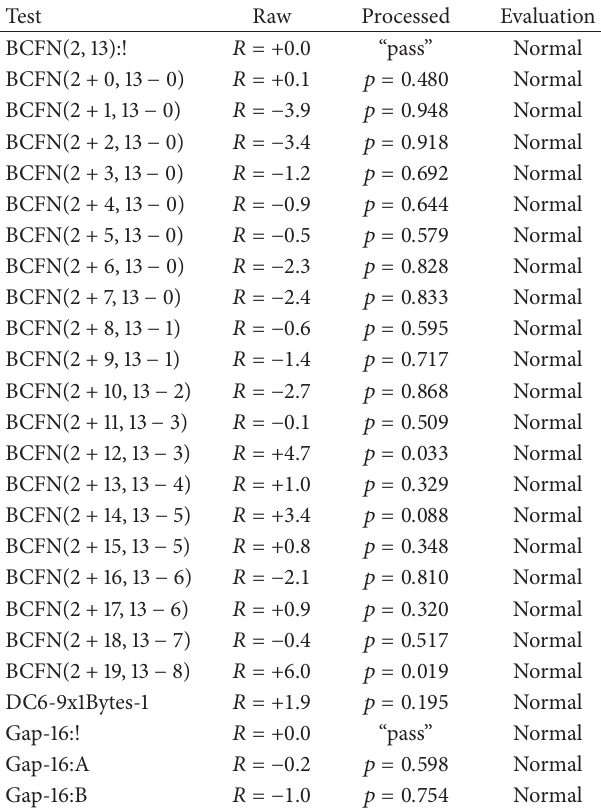
Table 3: PractRand results for a 64GB sequence.